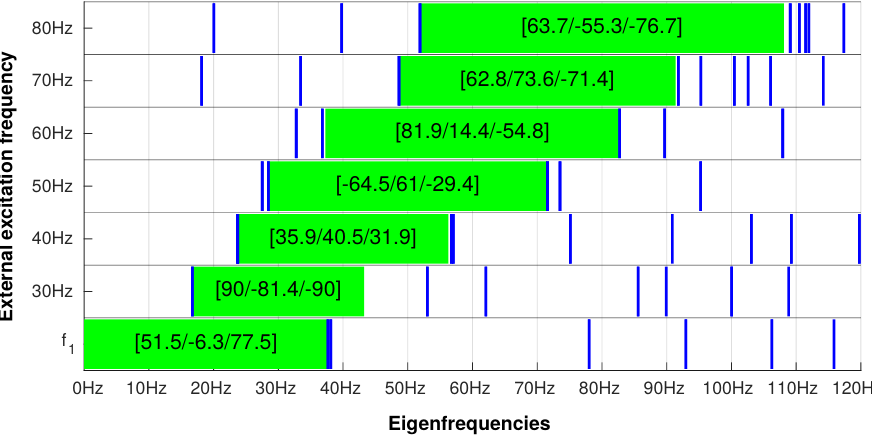
Figure 6. Optimization of the distance between natural frequencies and selected excitation frequencies with the ANN 1235 network and angle increment of ‘0’.